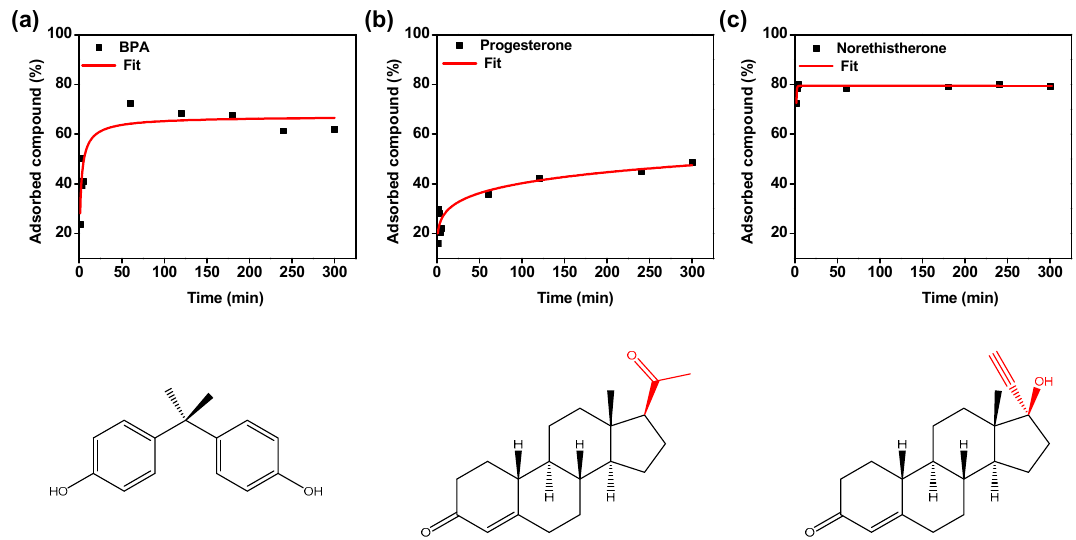
Figure 5. Effect of incubation time on the removal percentage of ( a ) bisphenol A (BPA), ( b ) progesterone and ( c ) norethisterone. Membranes 2020 , 10 , x FOR PEER REVIEW